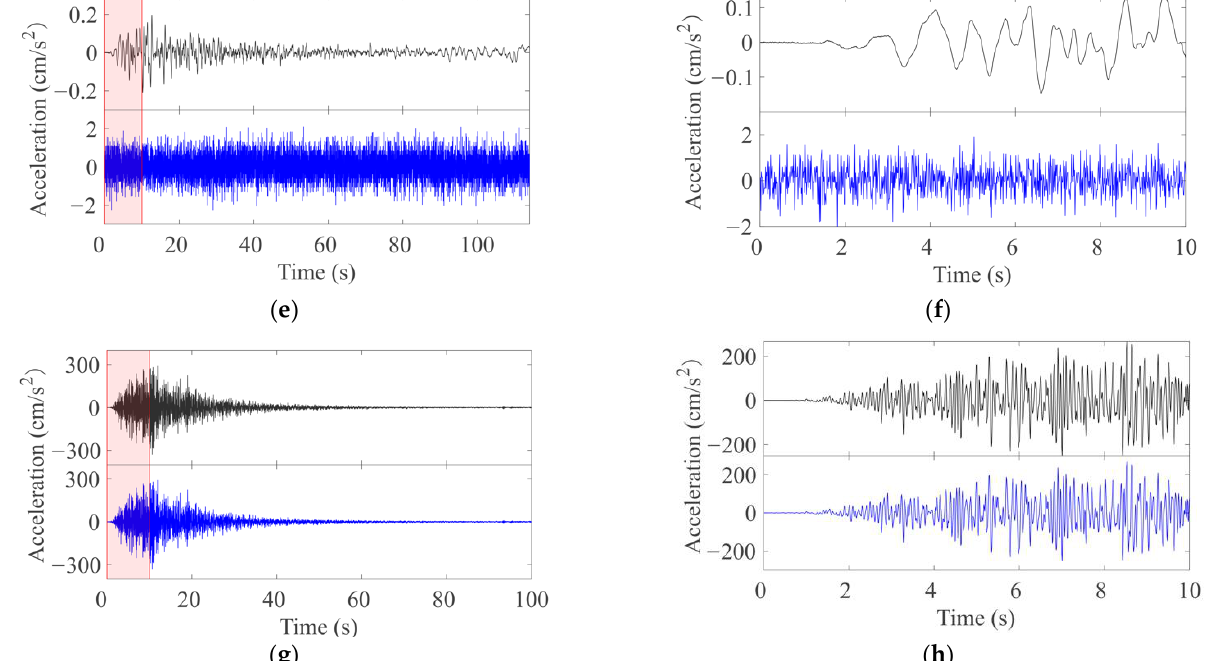
Figure 4. Comparison of seismic event acceleration waveforms before and after adding mobile phone sensor noise. The left column is the UD component of each earthquake event acceleration waveform, and the right column is the enlarged part of the corresponding left shadow area (0 – 10 s). The black line of each row is the data before adding noise, and the next blue line is after adding noise to the previous. ( a , b ): Near Earthquake, M 4.7, ∆ = 103.1 km , Station: SZO018; ( c , d ): Local Earthquake, M 4.7, ∆ = 26.3 km , Station: TYK009; ( e , f ): Near Earthquake, M 7.3, ∆ = 830.9 km , Station: SMNH16; ( g , h ): Local Earthquake, M 7.3, ∆ = 68.1 km , Station: FKSH20. M is the magnitude and ∆ is the epicentral distance.